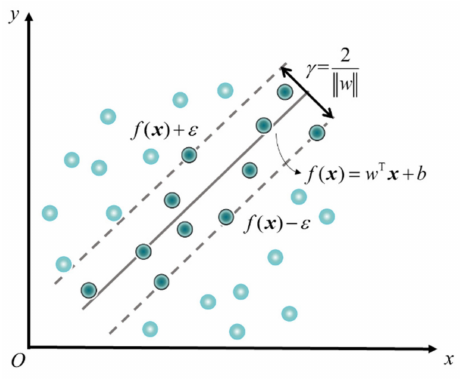
Figure 3. Diagram of SVR